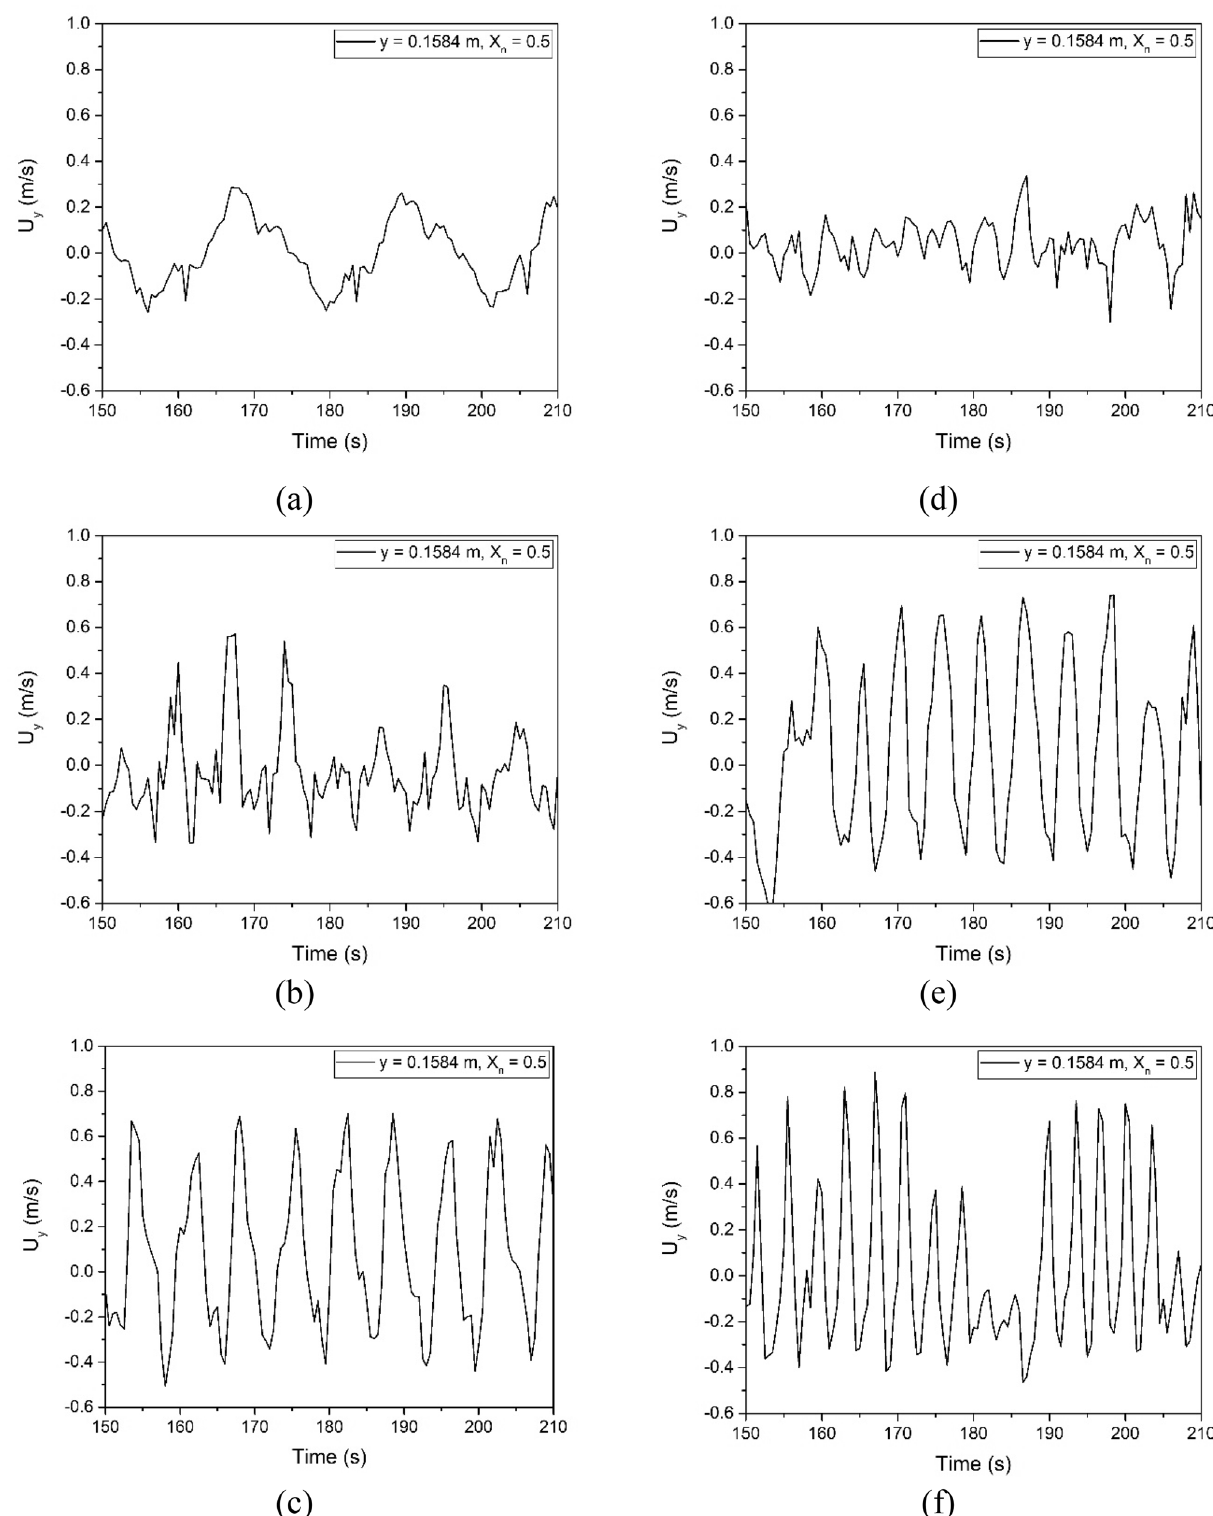
(18%), 2 mm bubble, d A1 (100%), 8 mm bubble; e A4 (69%), 8 mm bubble, f A7 (18%), 8 mm bubble (U